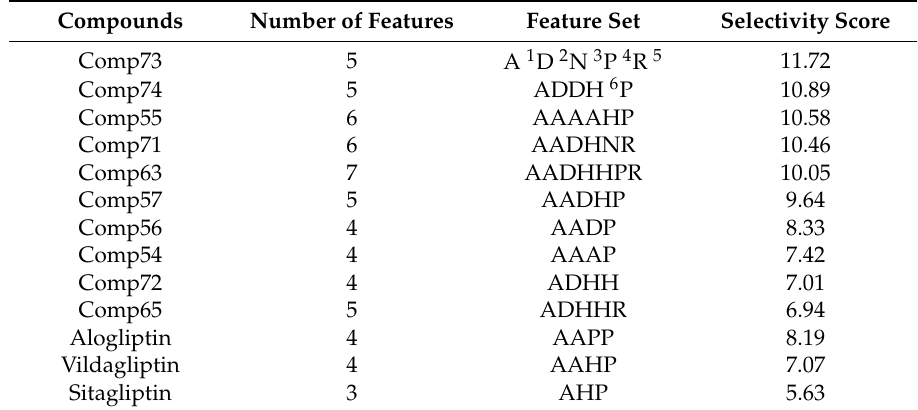
Table 2. The feature set and selectivity score for each compound based on Receptor-Ligand Pharmacophore Generation.